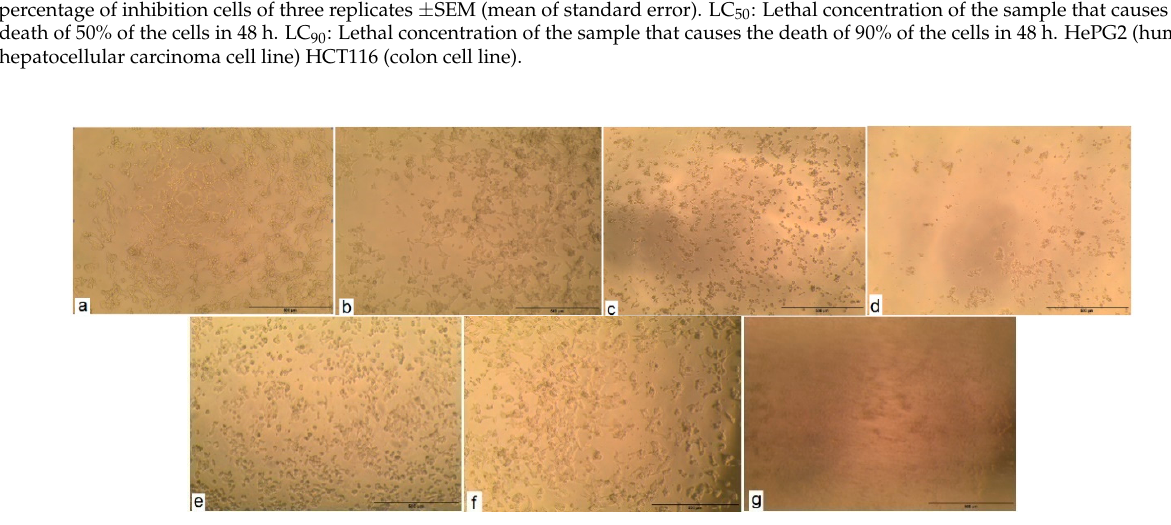
Figure 2. Cytotoxic activity against HCT116 cell line. ( a ): HCT116- E. oil —12.5 µg / mL. ( b ): HCT116- E. oil —25 µg / mL. ( c ): HCT116- E. oil —50 µg / mL. ( d ): HCT116- E. oil —100 µg / mL. ( e ): HCT116 control before treatment. ( f ): HCT116- DMSO at 100 ppm. ( g ): HCT116-positive (Doxorubicin) at 100µg/mL.